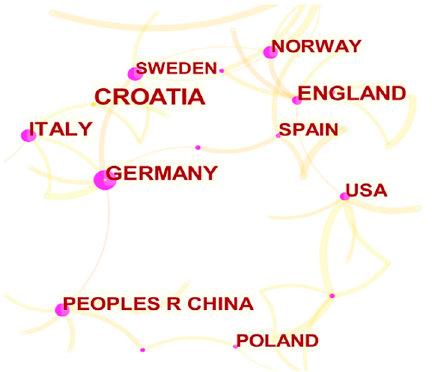
Figure 2. Paper publications per year.